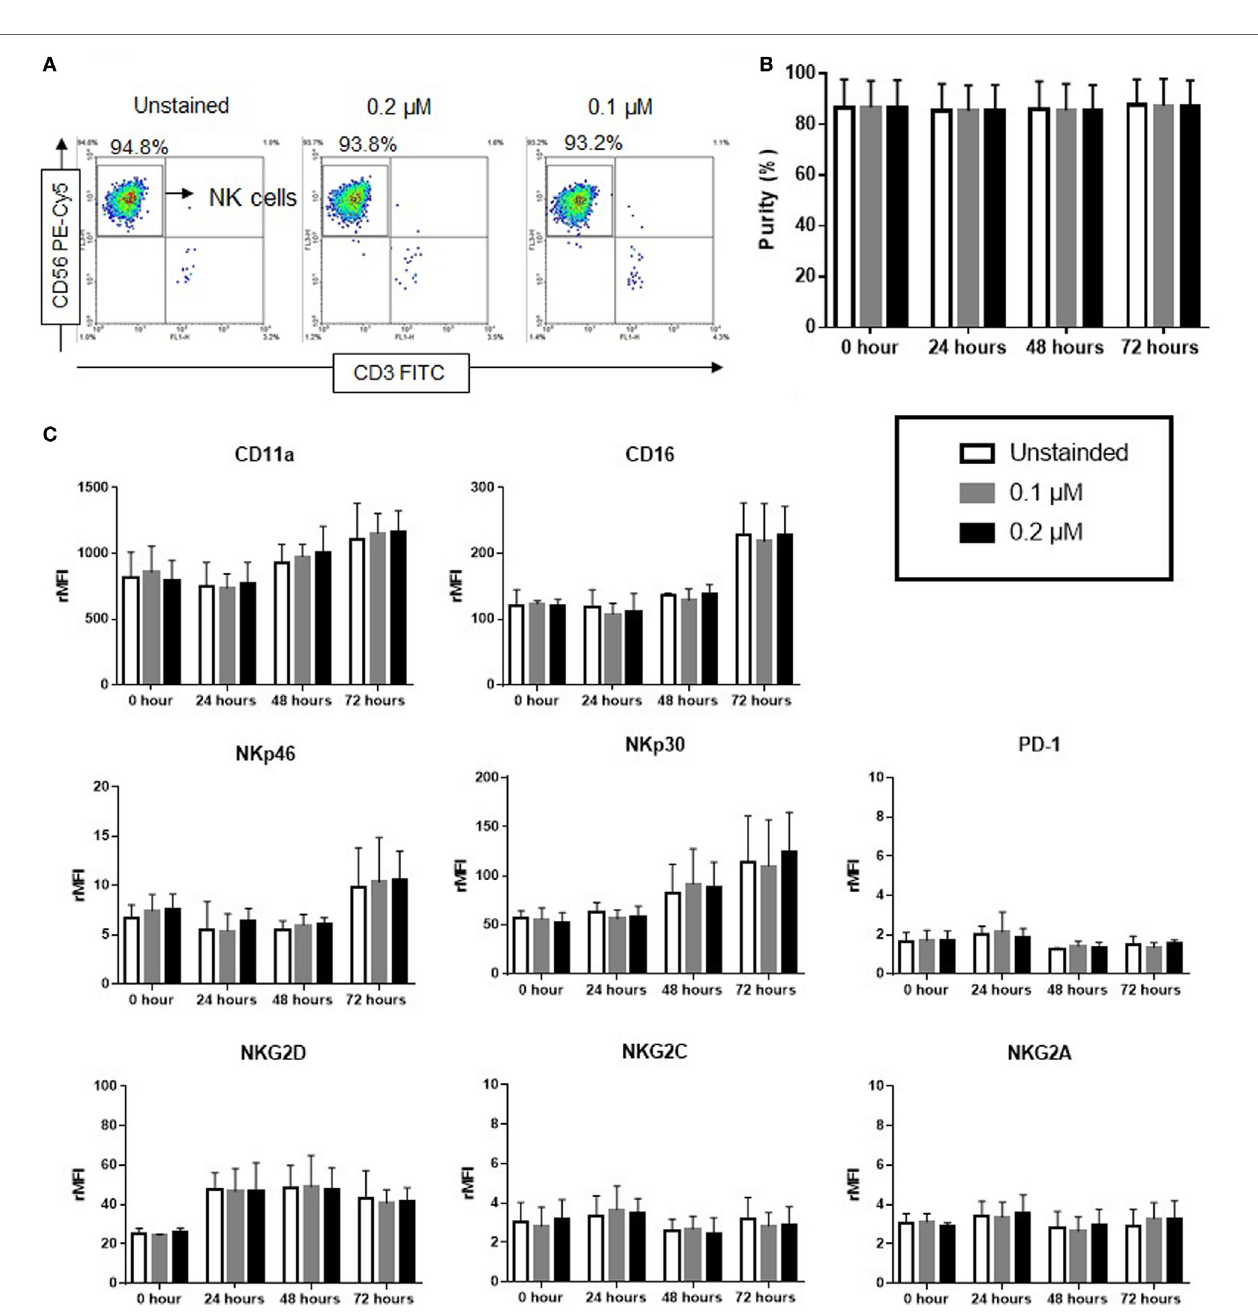
FigUre 1 | Optical imaging of near-infrared (NIR) fluorophore-stained natural killer (NK) cells in vitro . Expanded NK cells were stained with ESNF13 at different concentrations and evaluated at each designated time point. (a) Optical imaging of NK cells stained with NIR fluorophore ESNF13 at different concentrations was performed using a Nikon Eclipse T i -U inverted microscope system. (B) ESNF13-stained NK cells were pictured using an Olympus IX71 microscope. (c) Proliferation of ESNF13-stained NK cells by cell counting. The bar diagrams represent the number of NK cells (million cells). (D) Proliferation of NK cells as determined by a WST-8 proliferation assay. The bar diagrams present the proliferation percentage (%) compared with the control group. Data represent the mean ± SD from three independent experiments. Asterisk (*) indicates p < 0.05 in paired sample t -test